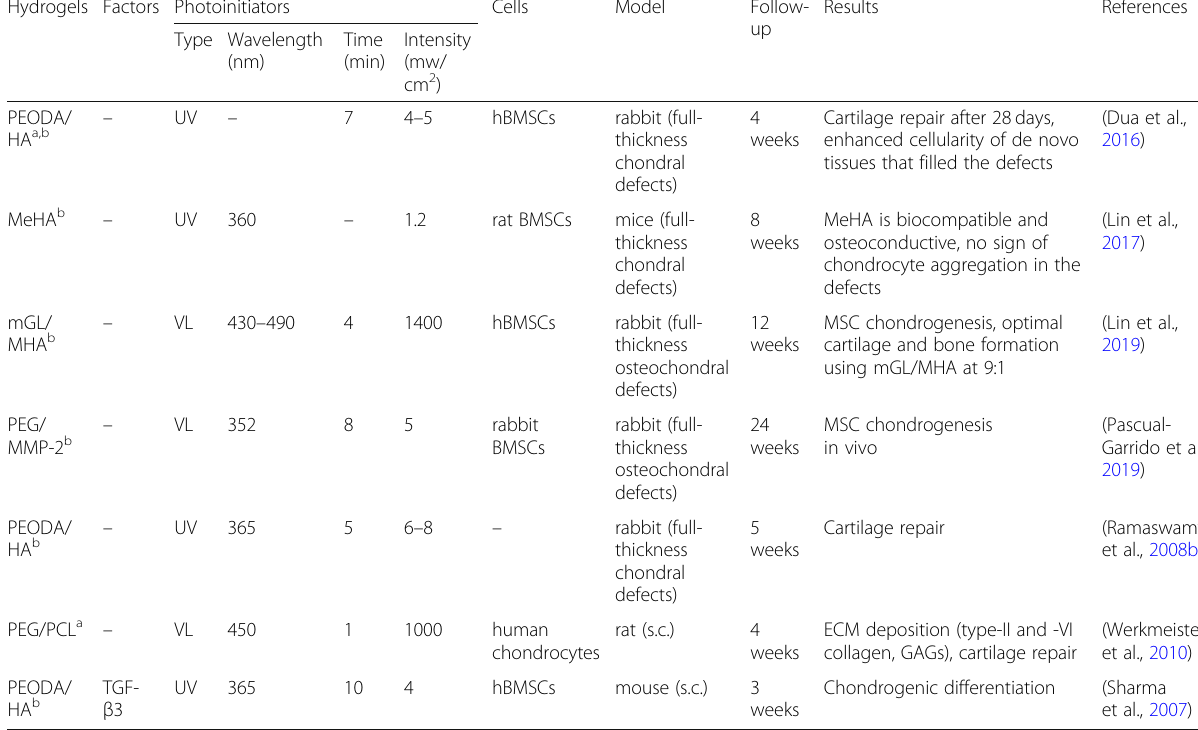
Table 2 Use of photopolymerizable hydrogels in vivo for applications in cartilage research Hydrogels Factors